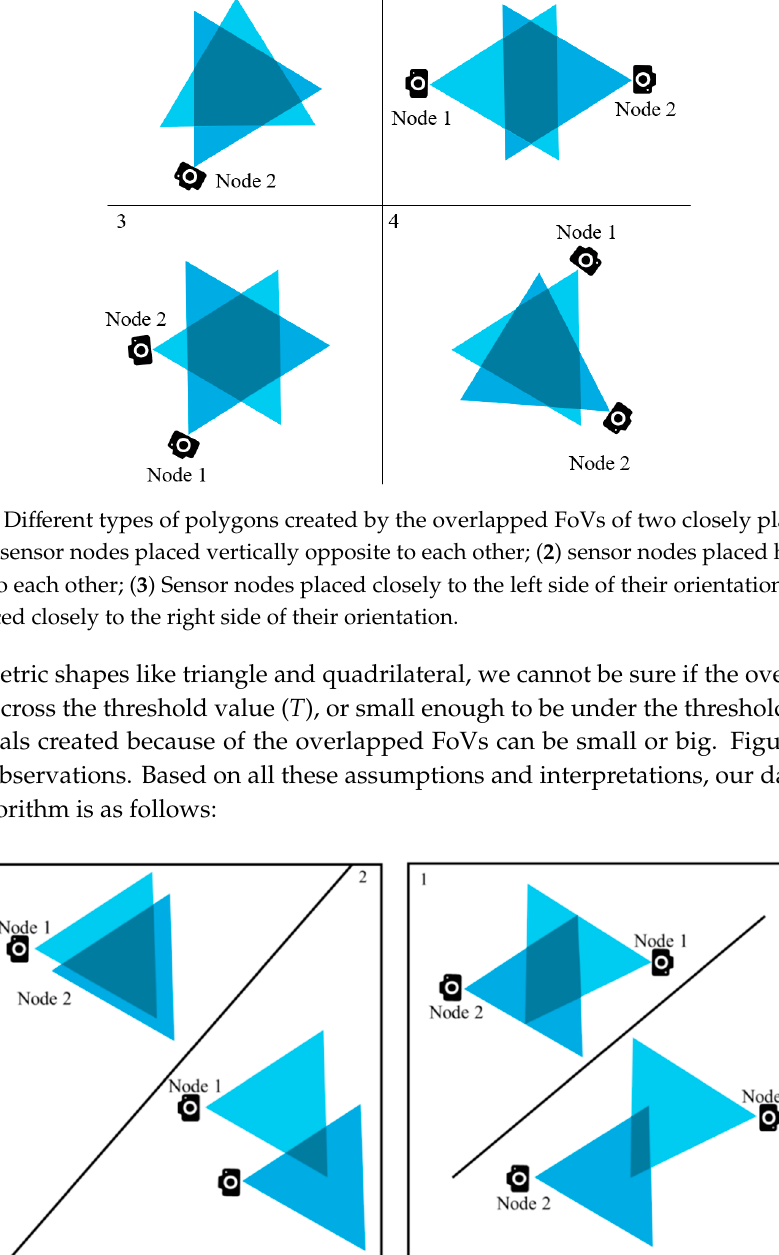
Figure 11. Different sizes of ( a ) triangles and ( b ) quadrilaterals created because of the overlapped FoVs.